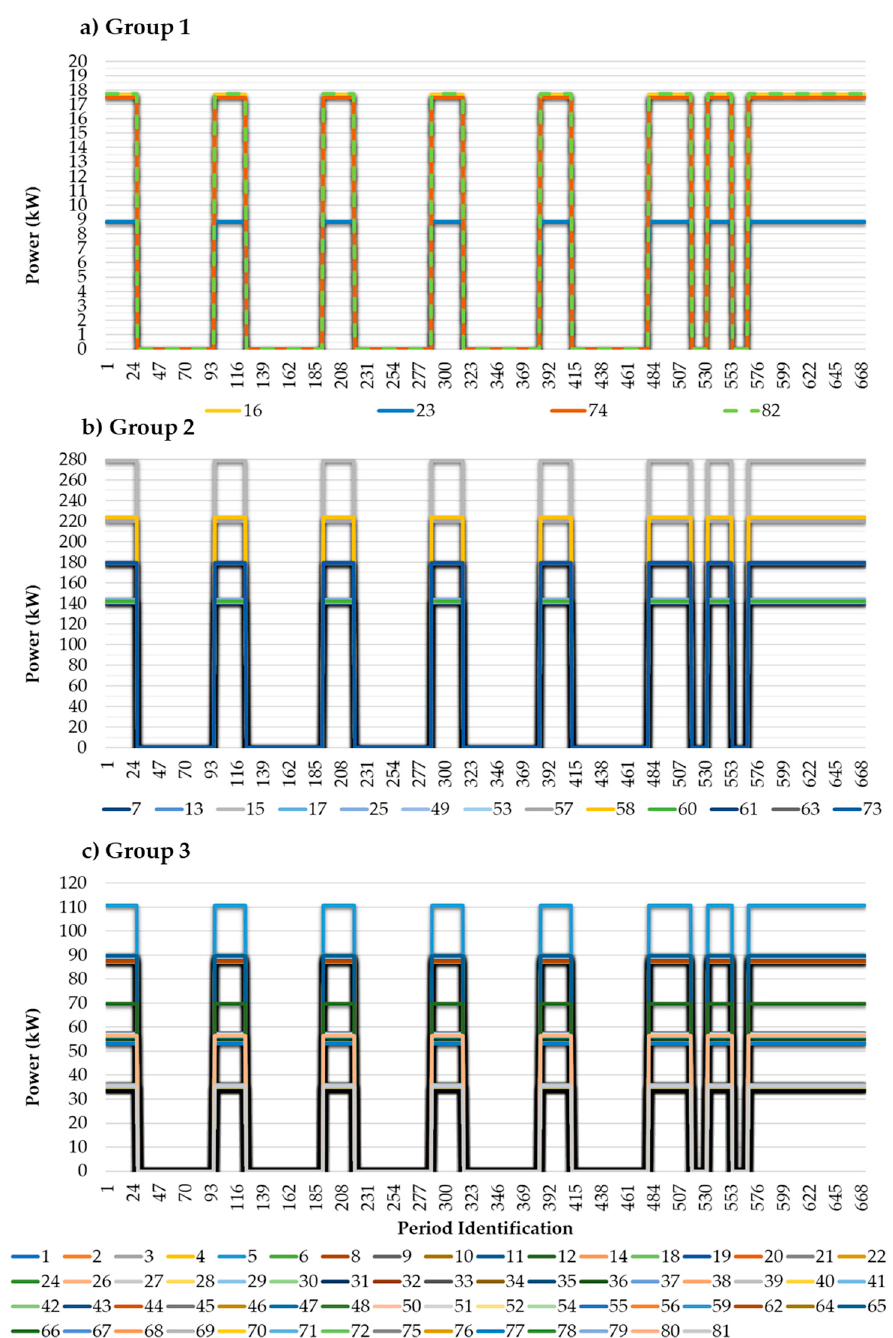
Figure 8. Results of the optimization for Medium Commerce consumers belonging to IDR.